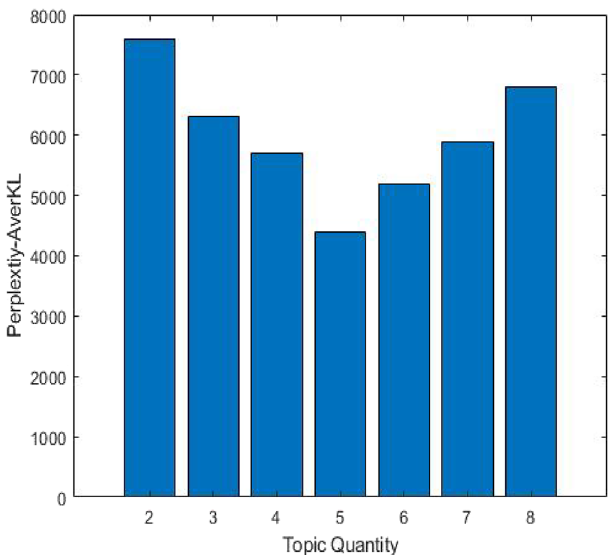
Figure 6. The relationship between the Perplexity-AverKL and the topic quantity.